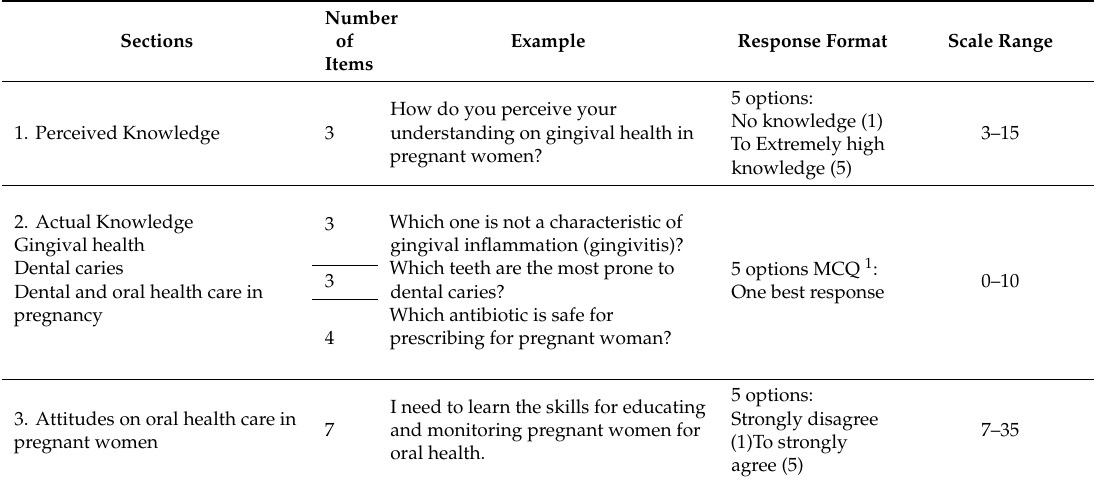
Table 1. Questionnaire scales, items within scales, response formats and scoring range for each scale.